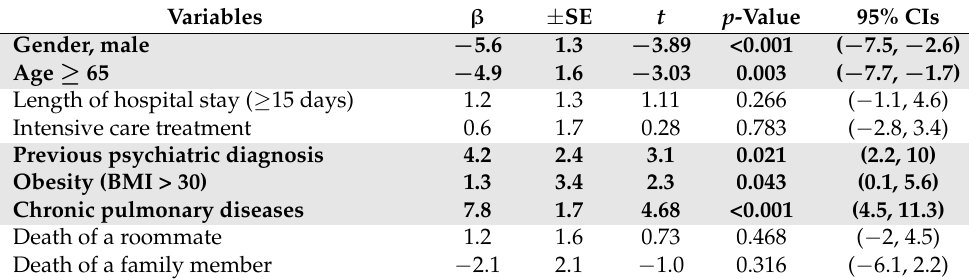
Table 2. Random intercept model prediction of PCL-5 total score over